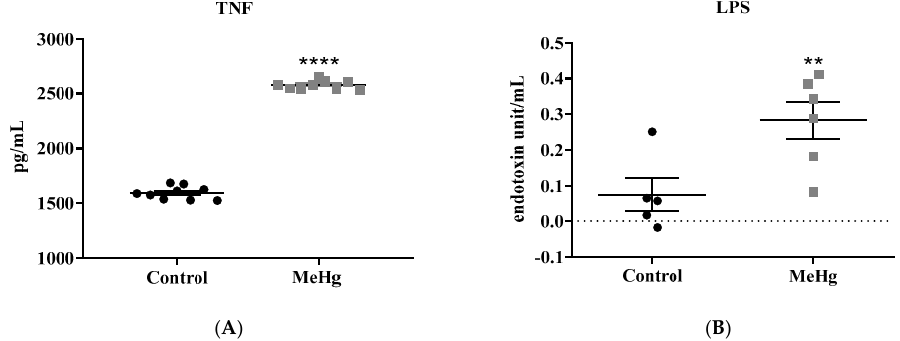
Figure 2. Effect of the oral administration of MeHg (2 mg/L) over 30 days on the systemic inflammation markers. Quantification of plasma TNF ( A ) and LPS ( B ). Values are expressed as mean ± SEM, n = 6 per group. **** p < 0.0001, ** p = 0.01 vs. control by the unpaired Student t -test.